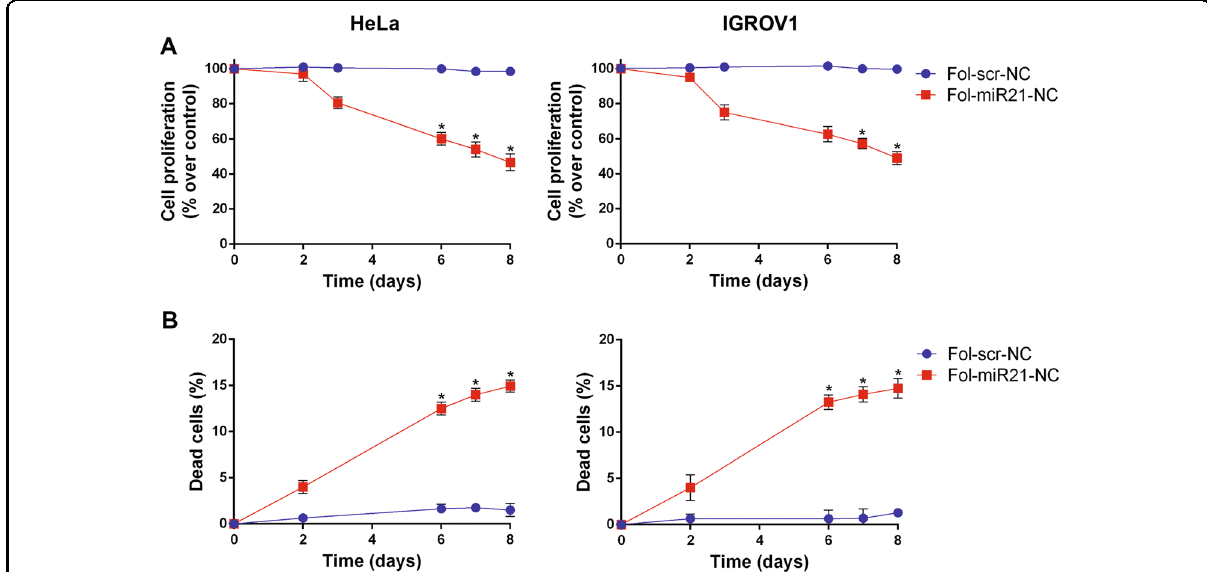
Fig. 6 Cytotoxic effect of Fol-miR21-NCs in HeLa and IGROV1 cells. Cell proliferation after treatment with Fol-NCs at different times was assessed by MTS ( A ) and cell death was evaluated by trypan blue assay ( B ). The values are the mean of six replicates normalized to untreated cells. Statistical signi fi cance: * P < 0.05 (Student ’ s t -test).